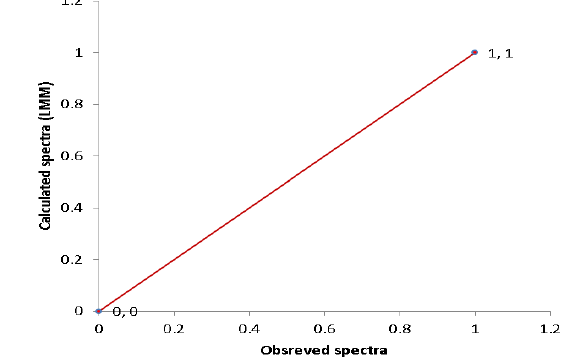
Figure 5: The expected scatter plot when LMM holds.